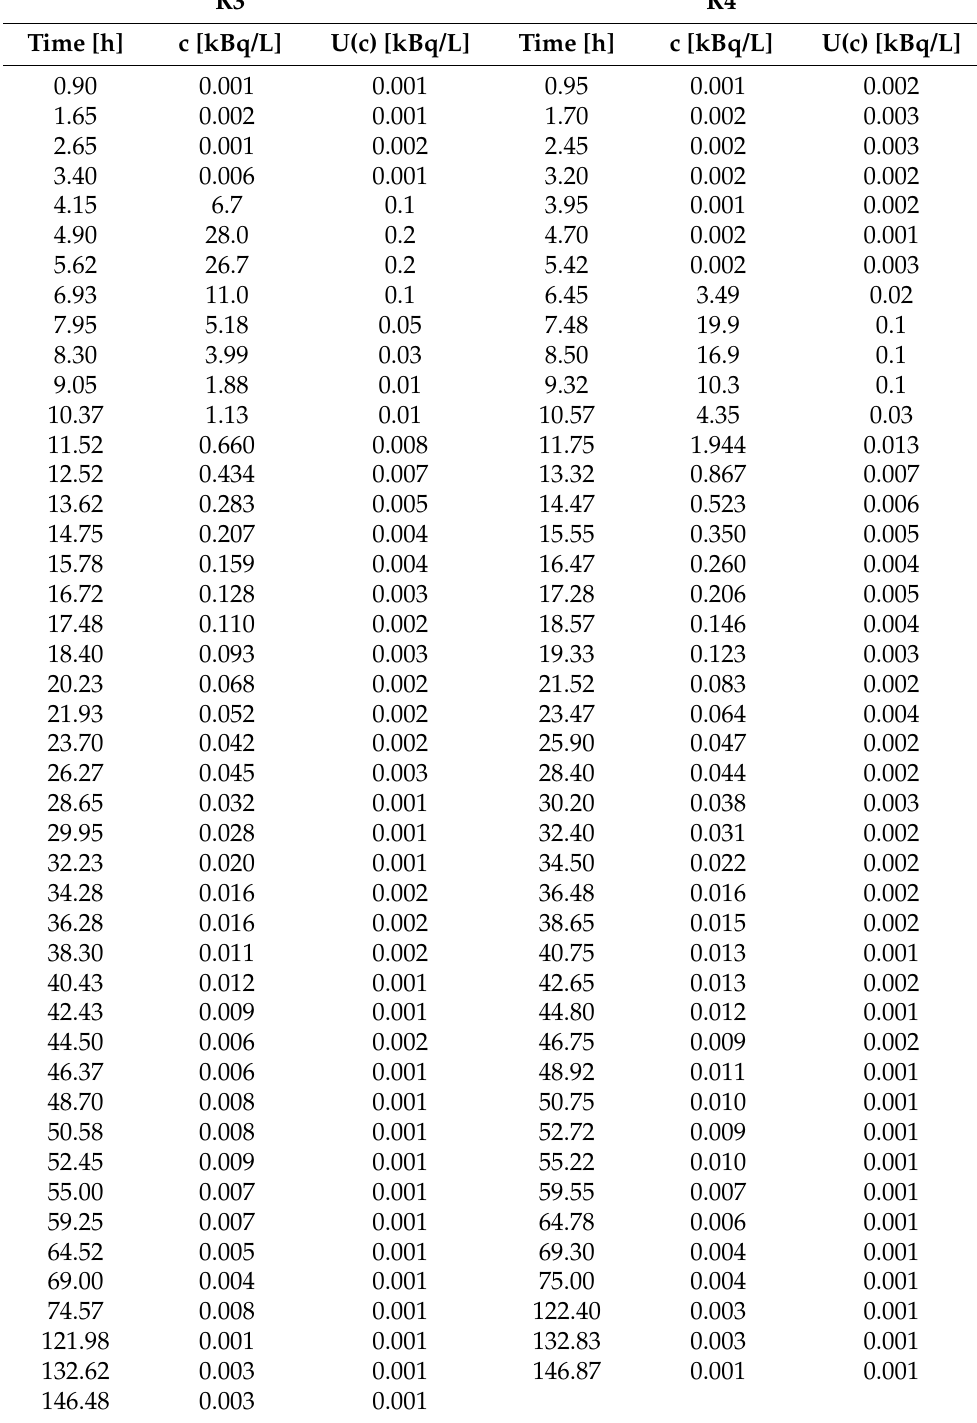
Table A2. In-stream 3 H activity concentrations and their analytical uncertainties at points R3 and